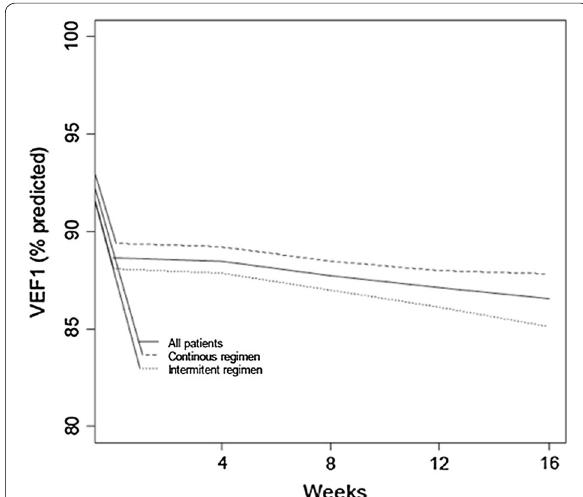
Fig. 4 Curve fitting for FEV1 (% predicted) from randomization to the end of the follow up of all (continuous line), intermittent (dotted line) and continuous (dashed line)